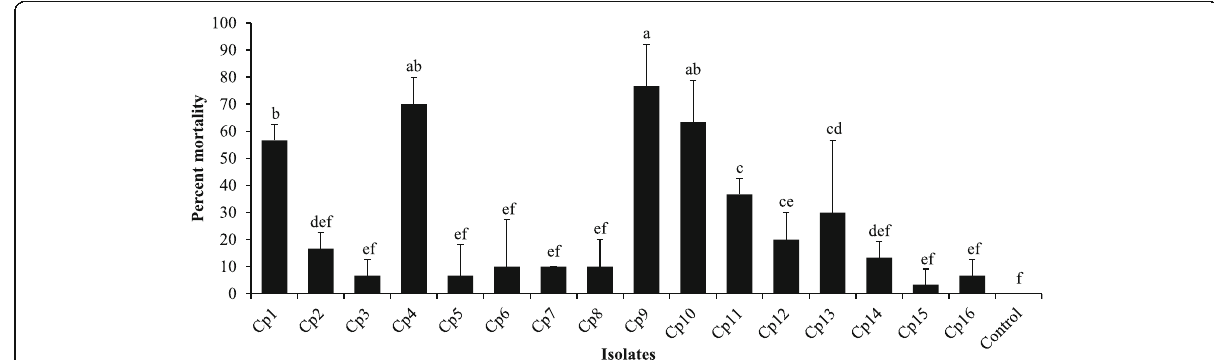
Fig. 2 Virulence of the bacterial isolates using the bacterial concentration of 1.89 × 10 9 cfu/ml against C. pomonella larvae within 10 days after application. Mortality data were corrected according to Abbott ’ s formula (Abbott 1925). Bars indicate standard deviation. Different lowercase letters represent statistically significant differences among larval mortalities. Cp1 Pseudomonas sp., Cp2 Corynebacterium sp., Cp3 Pseudomonas sp., Cp4 Bacillus sp., Cp5 Pseudomonas sp., Cp6 Pectobacterium carotovorum , Cp7 Bacillus sp., Cp8 Paenibacillus , Cp9 Bacillus sp., Cp10 Bacillus sp., Cp11 B. megaterium , Cp12 Bacillus sp., Cp13 Pseudomonas sp., Cp14 B. pumilus , Cp15 Bacillus sp., and Cp16 Terribacillus